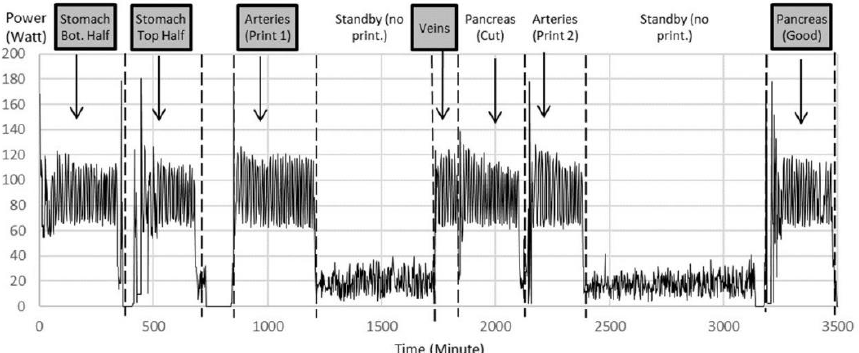
Figure 5. Power data during printing of multiple iterations of organ parts as examples to show power variation during printing between 120 W and 60 W with an average of 90 W. The printer consumes an average of 20 W during standby, when filament spools were exchanged and the corresponding printing code was uploaded to the printer. Notice multiple iterations for arteries and pancreas. Highlighted are the printed parts chosen for further experiments.